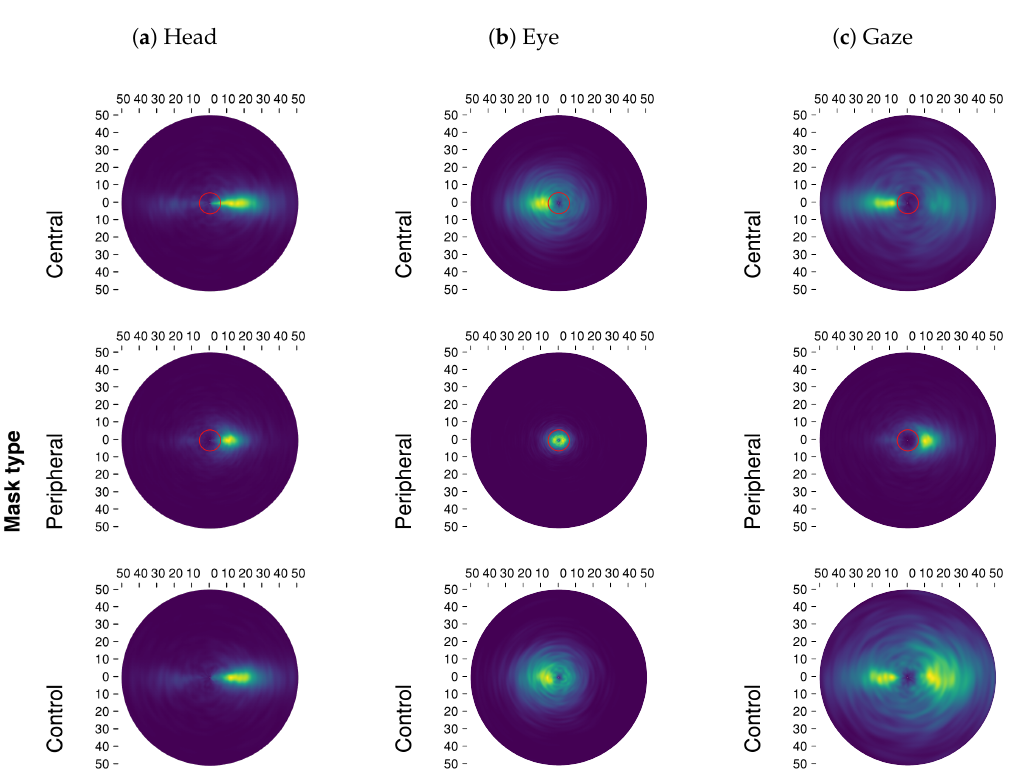
Figure 5. The joint distribution of saccade amplitudes and relative saccade directions are presented in this figure for eye, head and gaze as a function of mask conditions. Red circles at the center of the polar plots denote masks’ radius (six deg.). A brighter color represents a higher density of